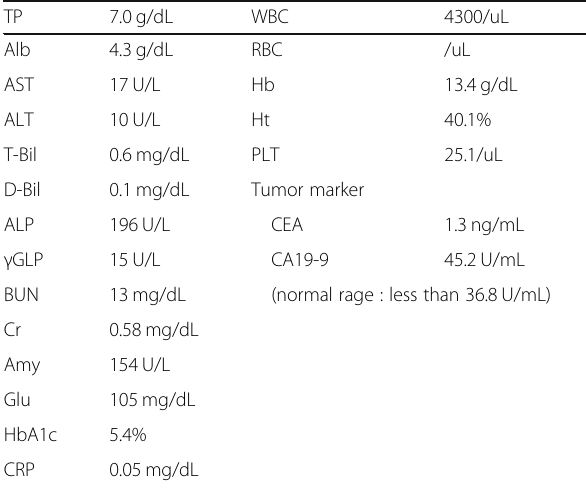
Table 1 Preoperative laboratory